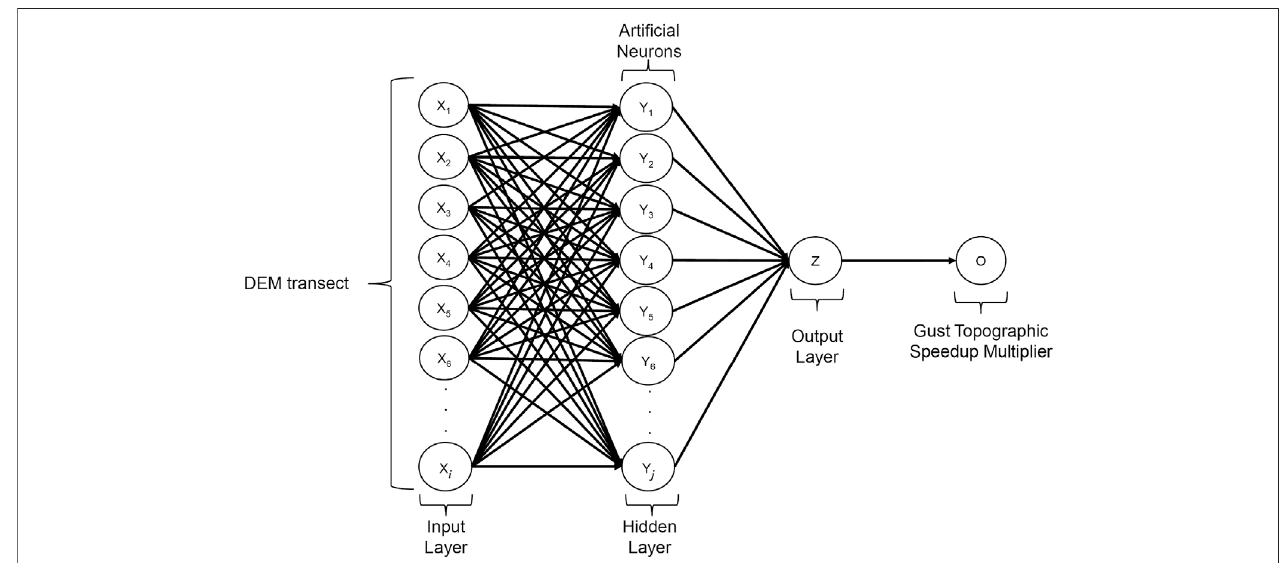
FIGURE 8 | Single Layer Network Architecture.